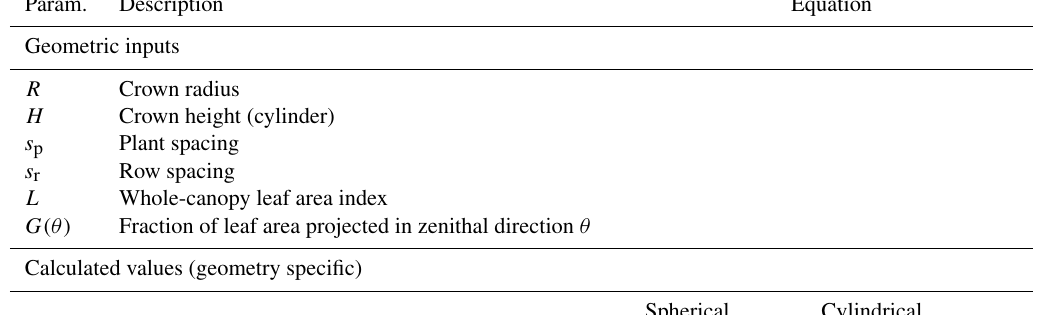
Table 1. Summary of inputs and equations needed to implement the BINOM model for canopies with spherical or cylindrical crowns. Param. Description Equation